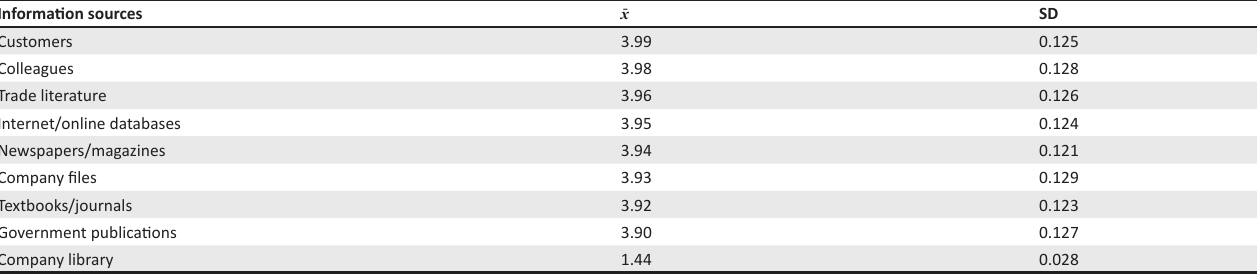
TABLE 2: Mean and standard deviation score of information utilisation (sources) of the respondents.